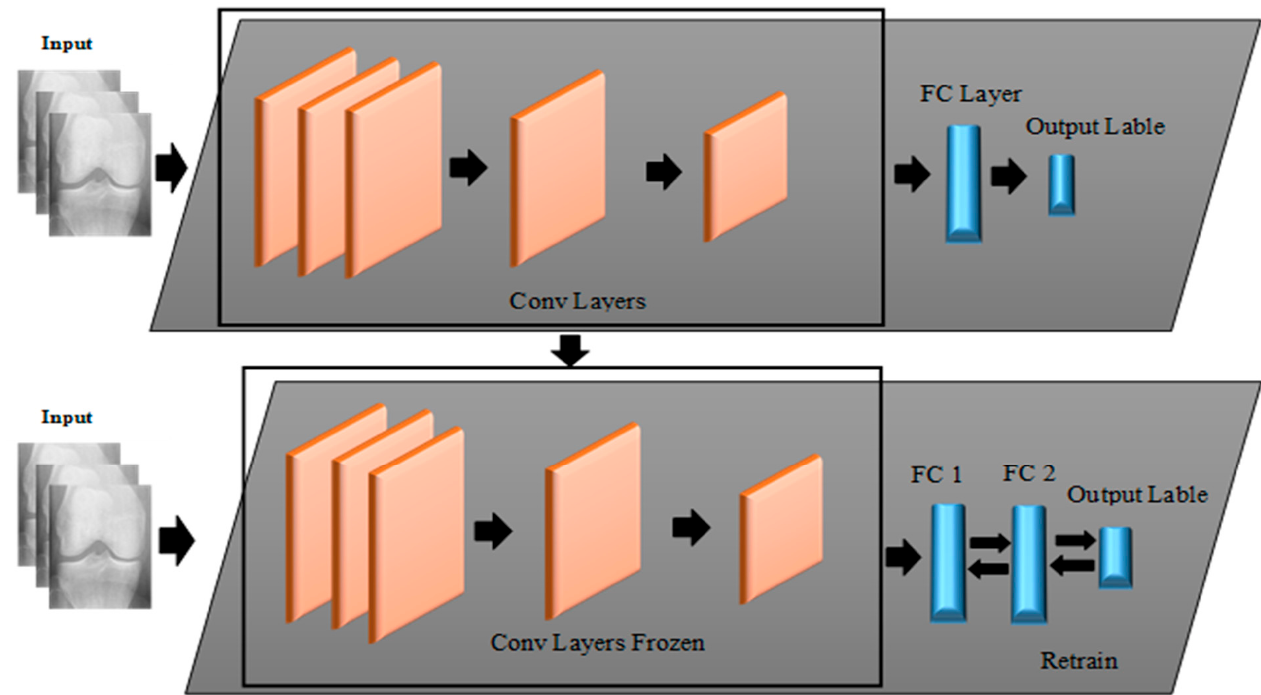
Figure 10. The block diagram of deep modeling for the fine-tuning transfer learning.